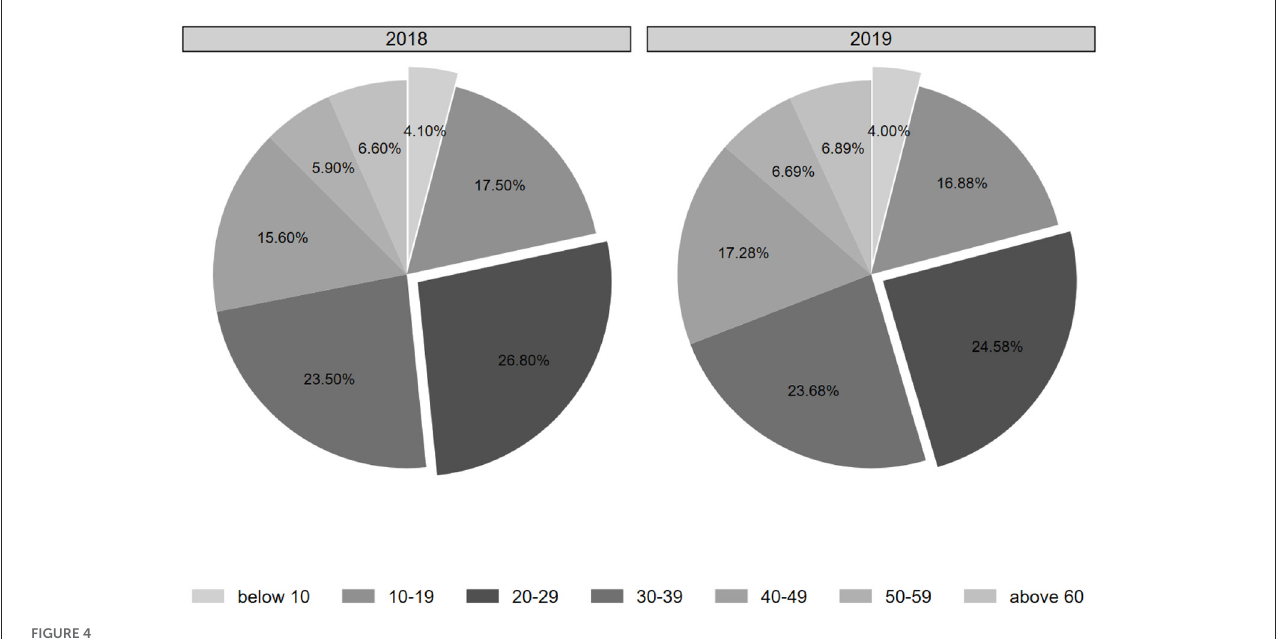
FIGURE4 The proportion of Internet users in different age